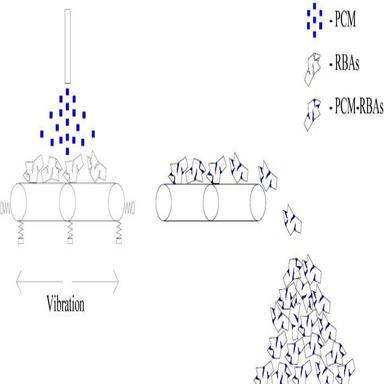
Filling of the RBAs through an advanced spray process .